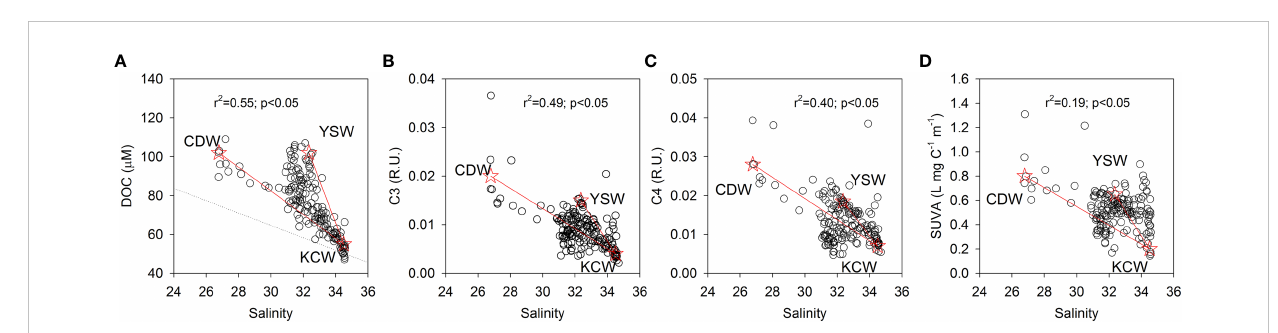
FIGURE 4 Correlations between the salinity and the concentrations of DOC (A) , C3 (B) , C4 (C) , and SUVA 350 (D) . Red stars and solid lines indicate the endmember values of each parameter and theoretical mixing line, respectively. The dotted line indicates the end-member mixing line.